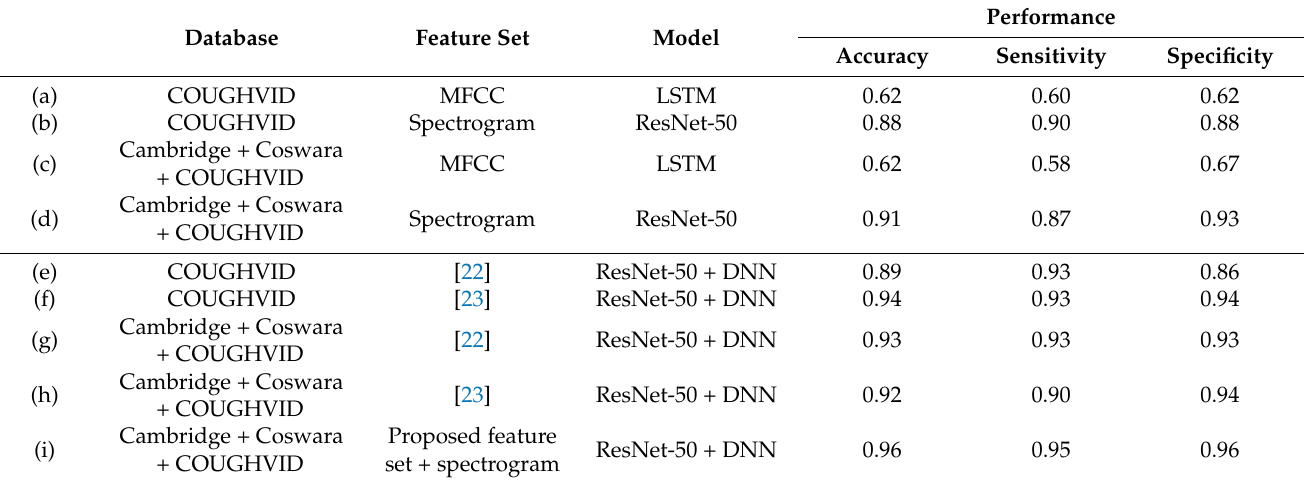
Table 5. Comparison of the results.